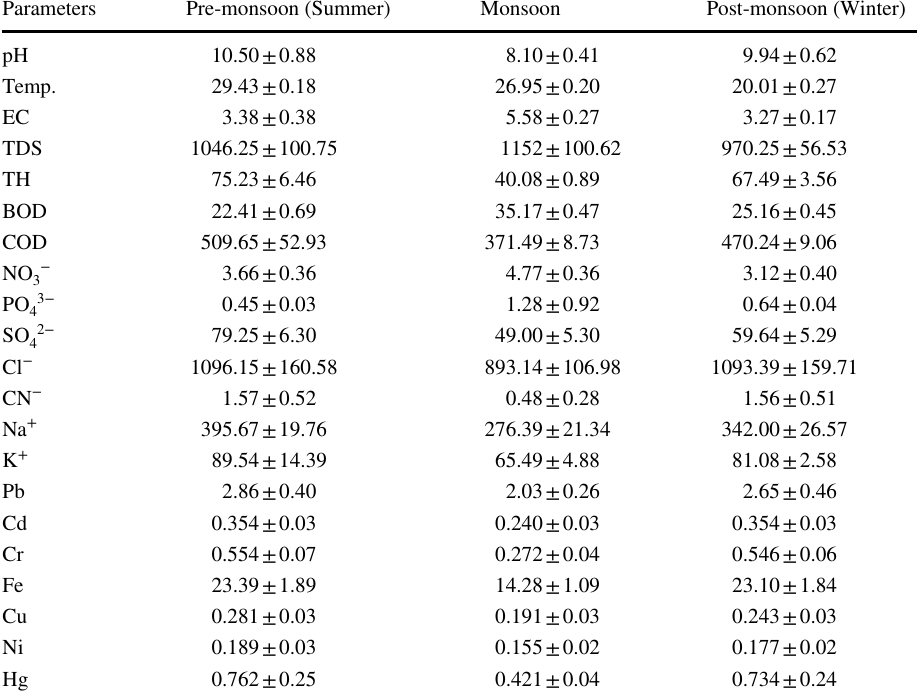
physicochemical parameters and heavy metal concentrations in stream water